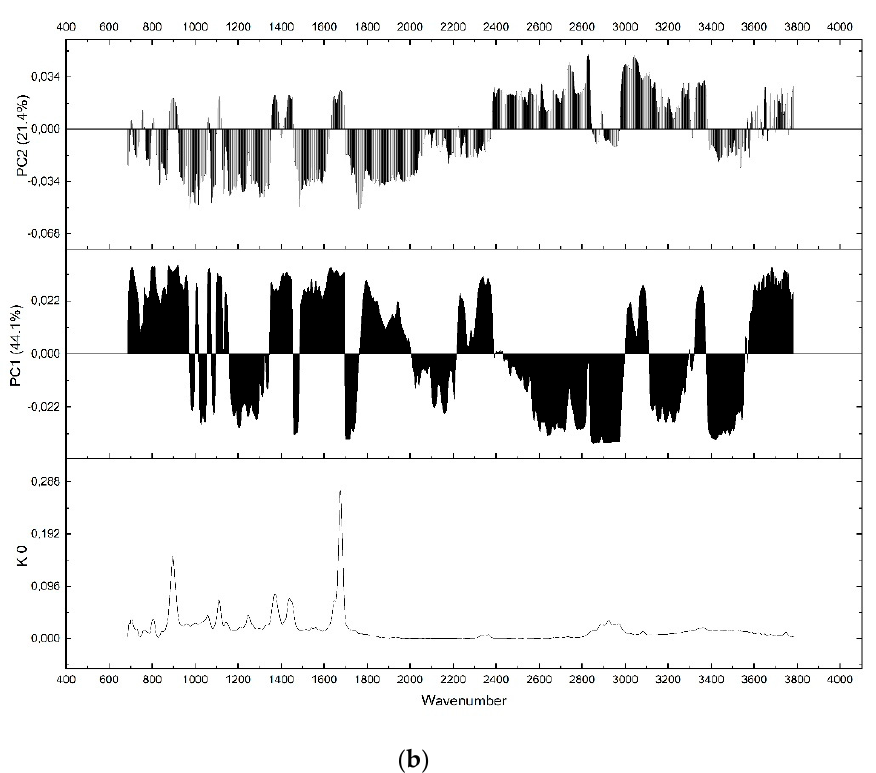
Figure 5. Loading plots of PC1 and PC2 for references spectra K0 ( a ) and M0 ( b ). Table 5. Values of Eigenvalue and percentage of variance with cumulative corresponding to each principal component.